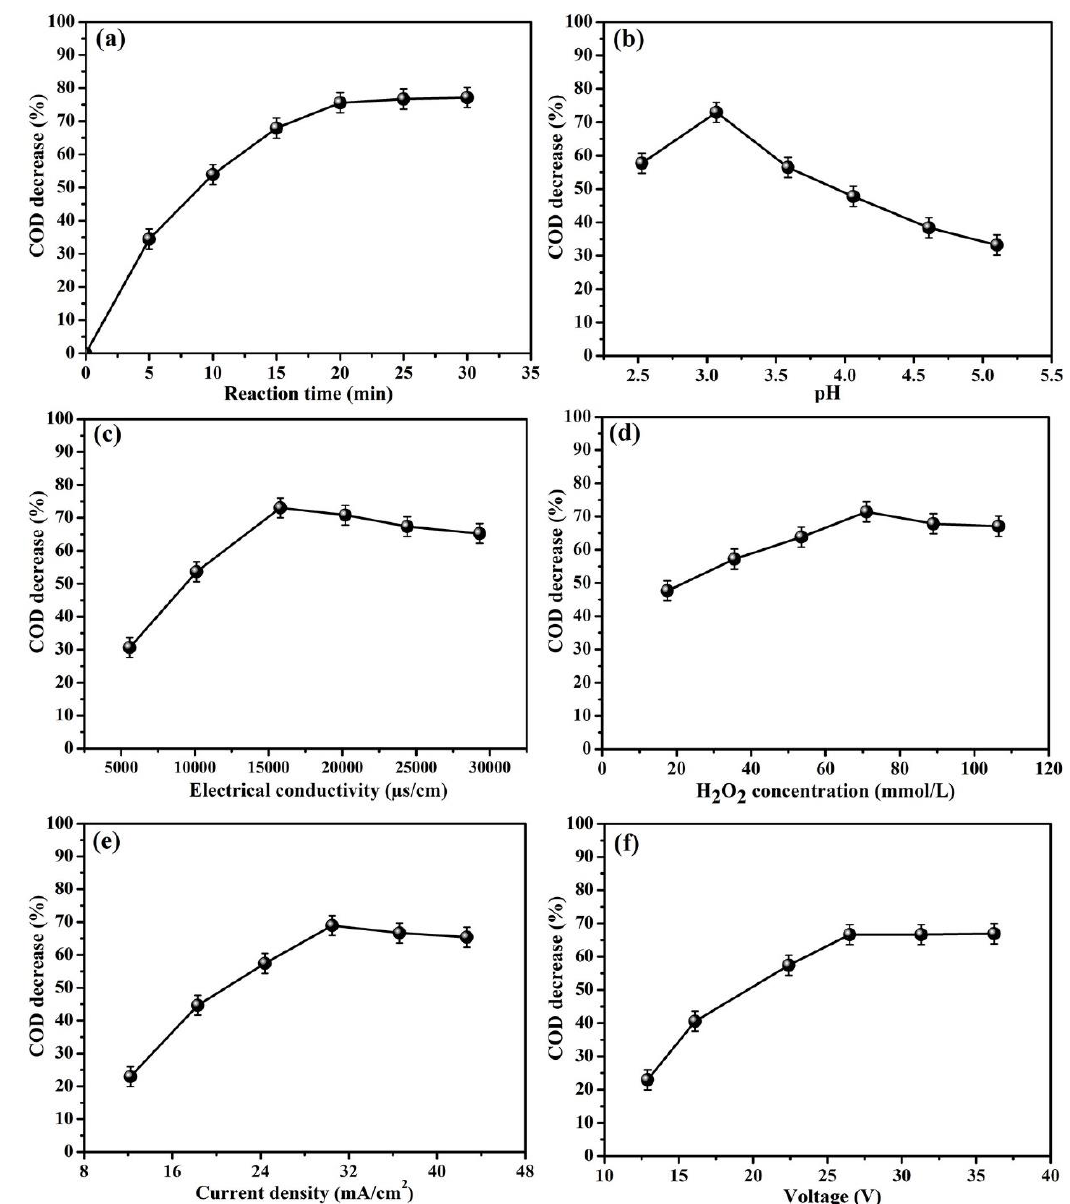
Figure 3. Effect of various process conditions on the chemical oxygen demand (COD) decrease efficiency of quinoline solution in electro-Fenton reaction. ( a ) Reaction time, ( b ) pH value, ( c ) electrical conductivity, ( d ) H 2 O 2 concentration, ( e ) current density, and ( f ) voltage.